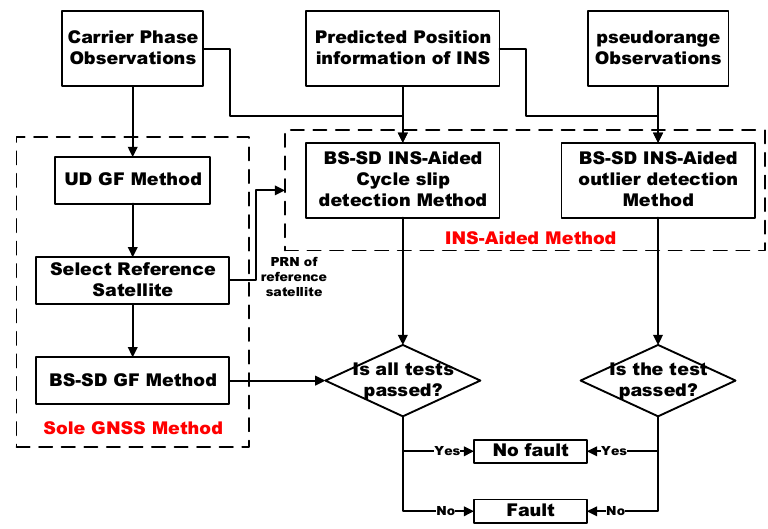
Figure 5. Single-station fault detection flowchart.